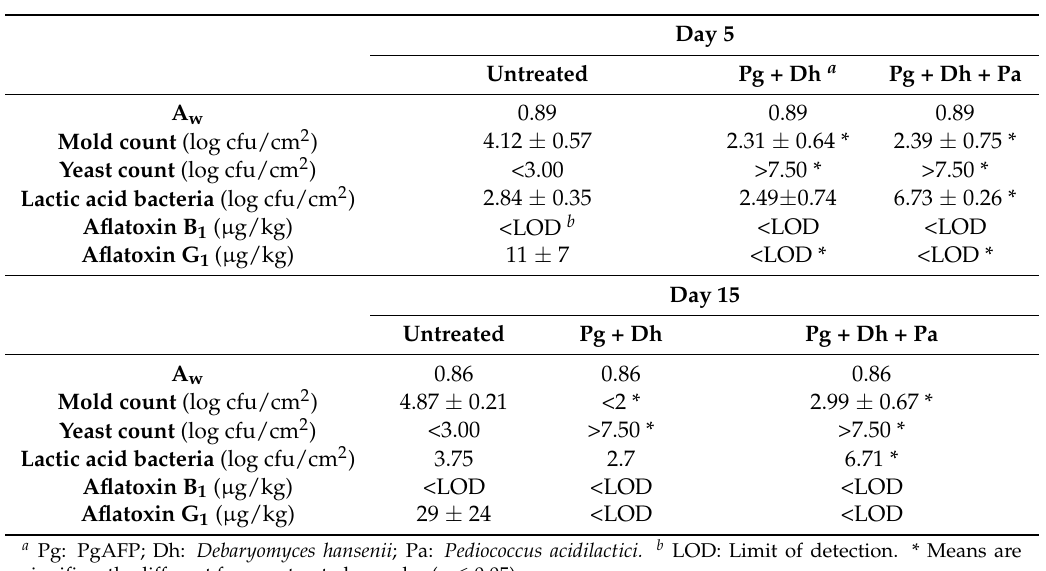
Table 3. Water activity (a w ), microbial counts and aflatoxins concentration in cheese slices inoculated with A. parasiticus at five and 15 days of incubation. Data are given as mean ± SD.